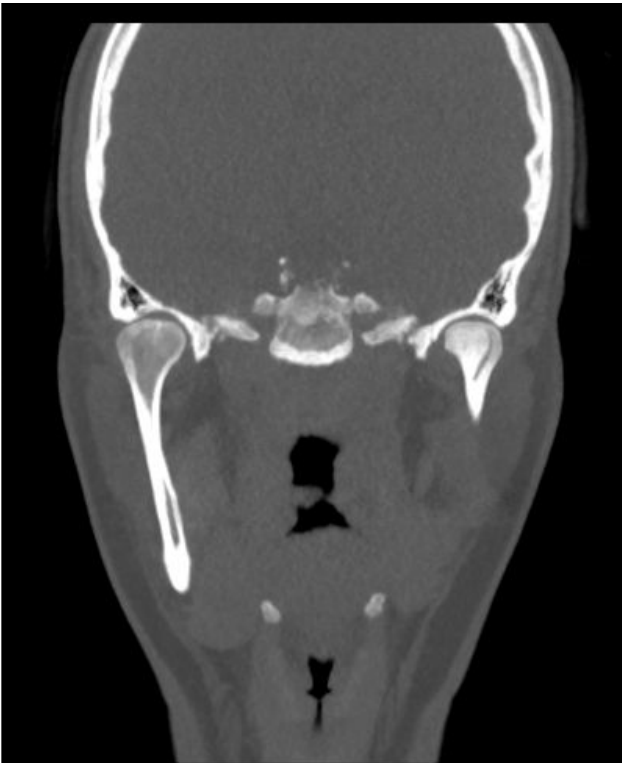
Figure 4. LDCT coronal view on the condylar head. Notable bone osteosclerosis and right con dyle head enlargement with ramus elongation are